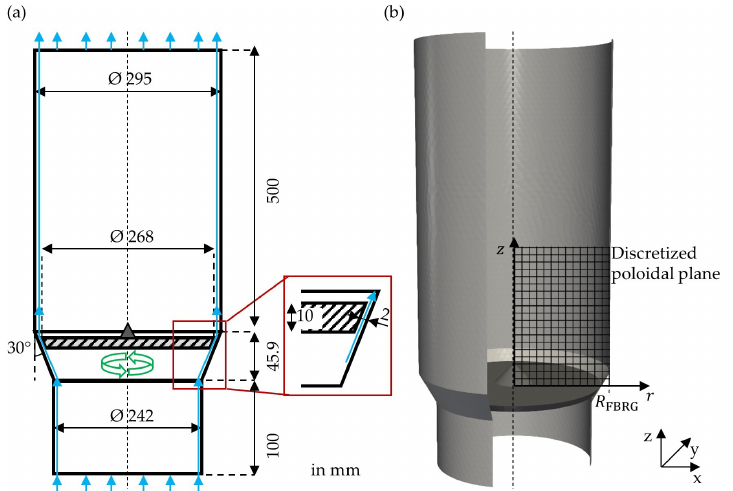
Figure 2. ( a ) Dimensions of the fluidized bed rotor granulator (blue arrows indicate the air flow and the green arrows the direction of rotation of the plate) and ( b ) its STL 3D geometry for the